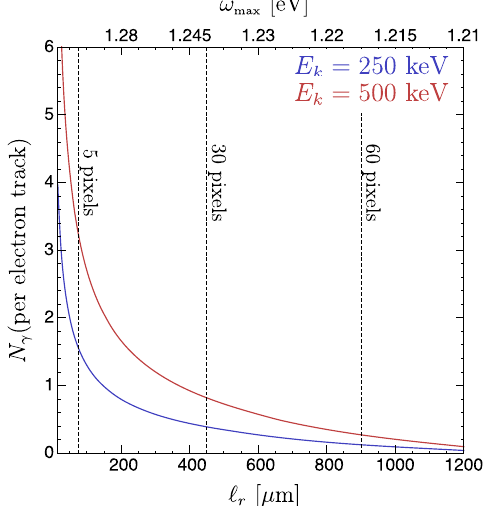
FIG. 16. Total number of photons produced by a single high- energy electron track passing through Si, which travel radially away from the track for a distance of at least l . Such photons r = sin θ have a mean-free path satisfying l γ ≥ l . The electron ’ s r Ch ¼ 250 keV (blue curve) or E ¼ 500 keV kinetic energy is E k k (red curve). The top x axis shows the maximum frequency that allows the photon to travel at least l . Vertical lines show the r dimensions corresponding to 5, 30, and 60 pixels in the Skipper CCD at